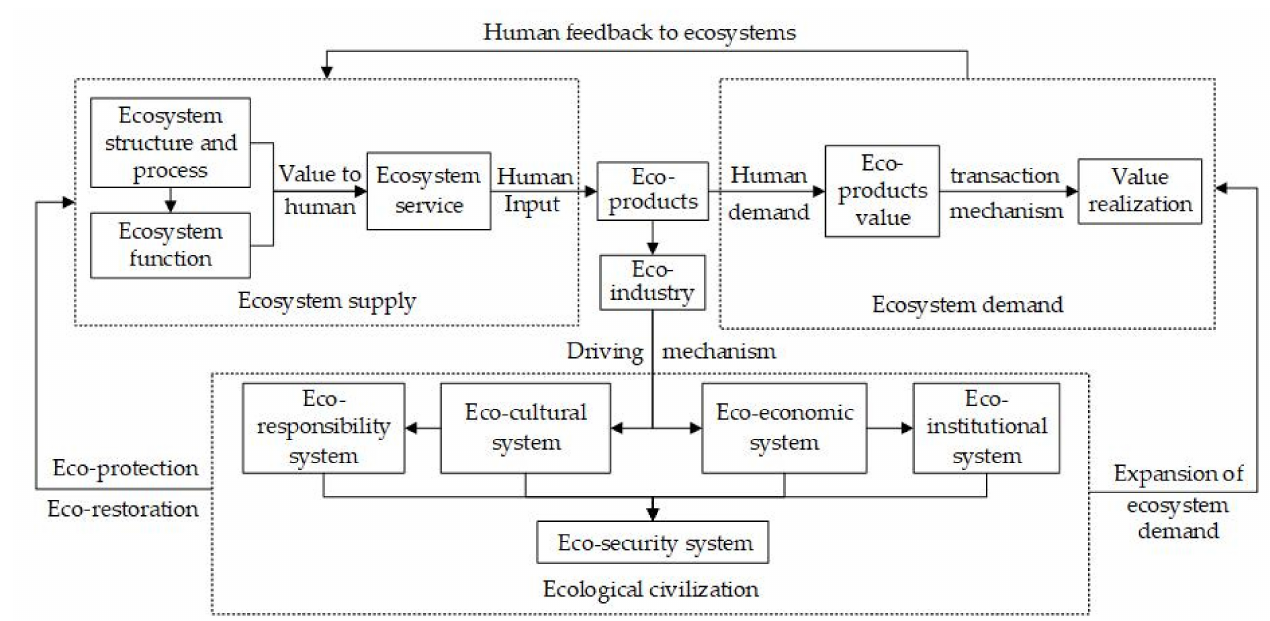
Figure 5. Research ideas on the eco-product value realization and ecological